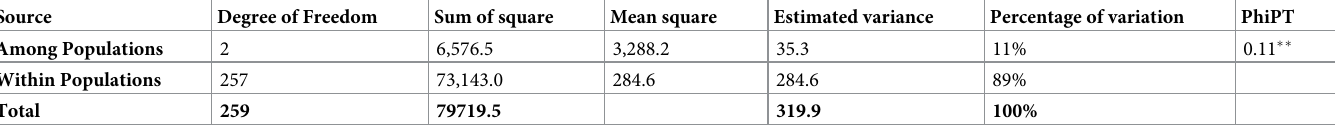
Table 3. Analysis of molecular variance (AMOVA) for the Ethiopian barley accessions for the three genetically distinct clusters; PhiPT values for the total population.